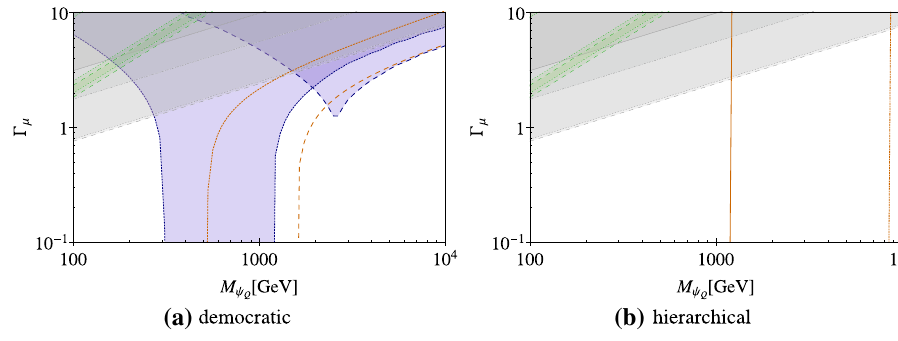
Fig. 11 Summary plot for Majorana DM in bIIB. The legend and an explanation of the color scheme are given in